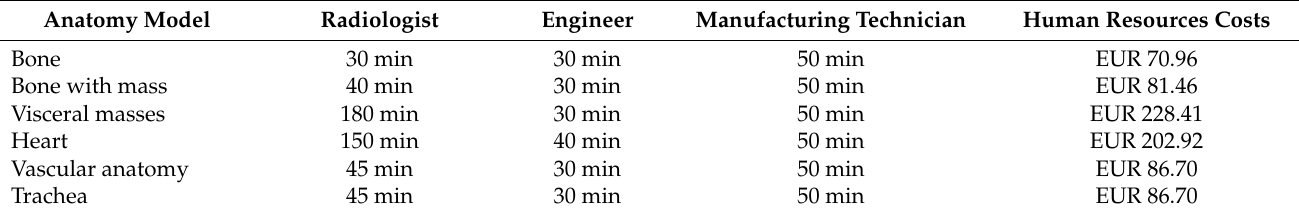
Table 4. Technician time and